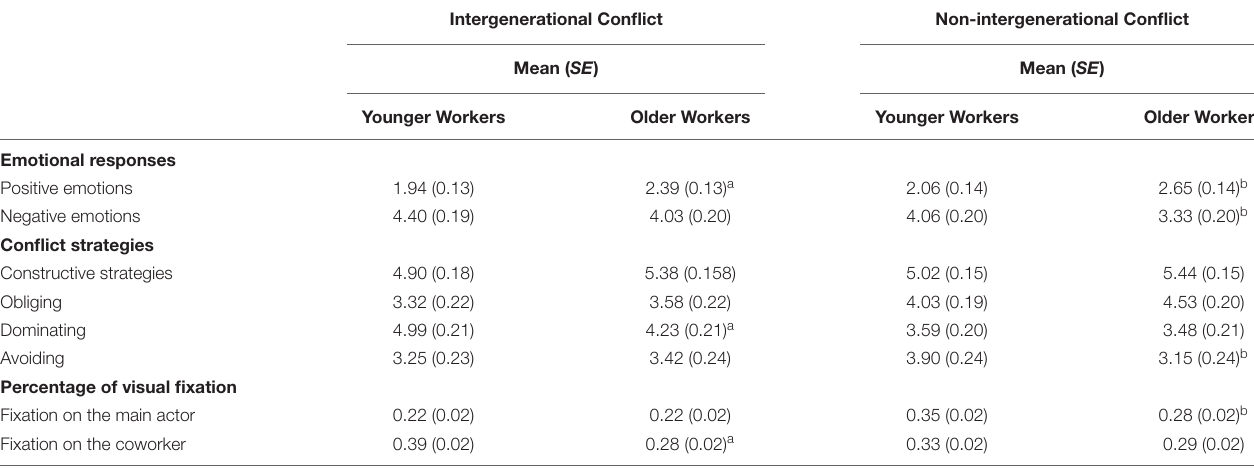
TABLE 1 | Descriptive statistics of emotional responses, conflict strategies, and visual fixation.